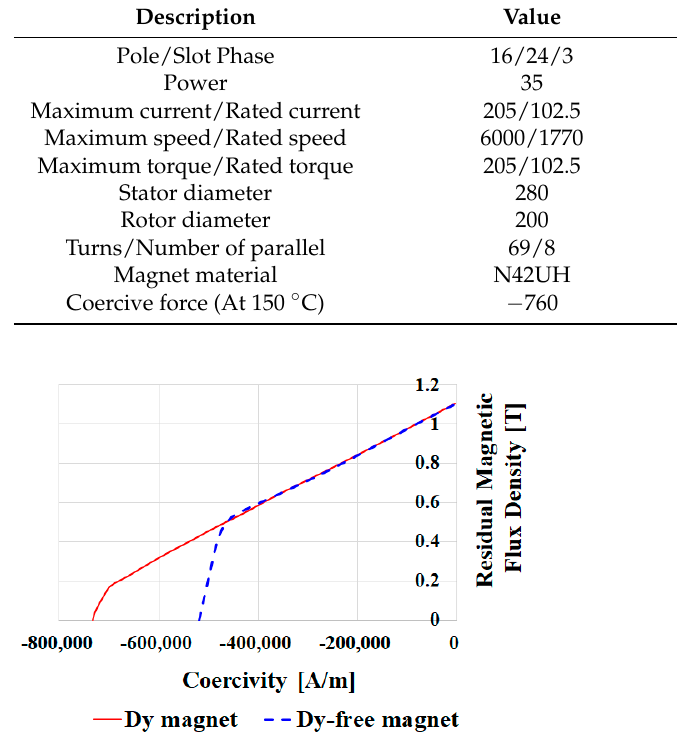
Figure 3. B-H curve of NdFeB and Dy − free NdFeB magnet (temperature: 150 °C).